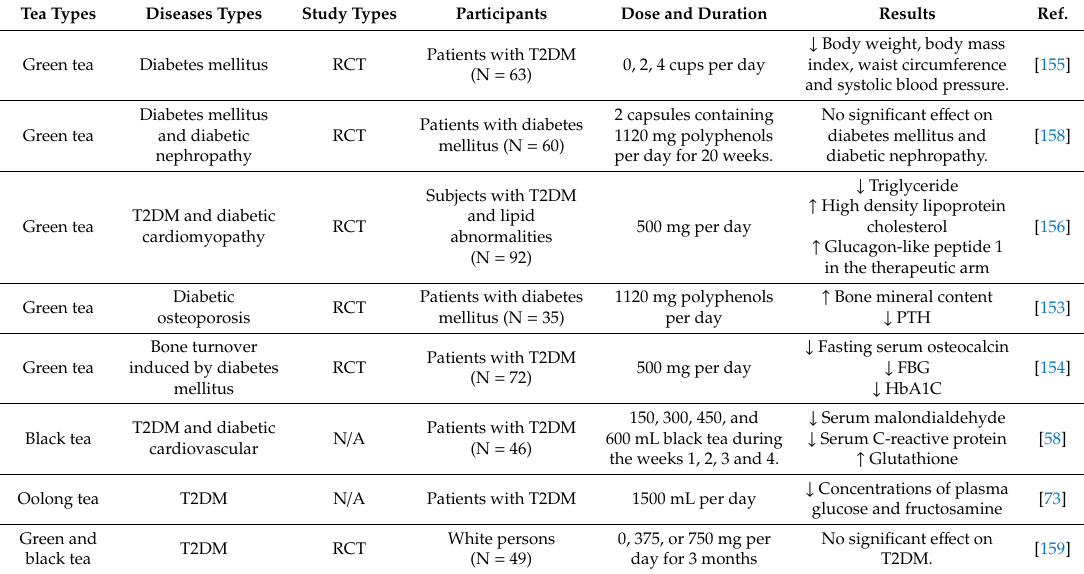
Table 3. The e ff ects of tea on diabetes mellitus and its complications based on clinical